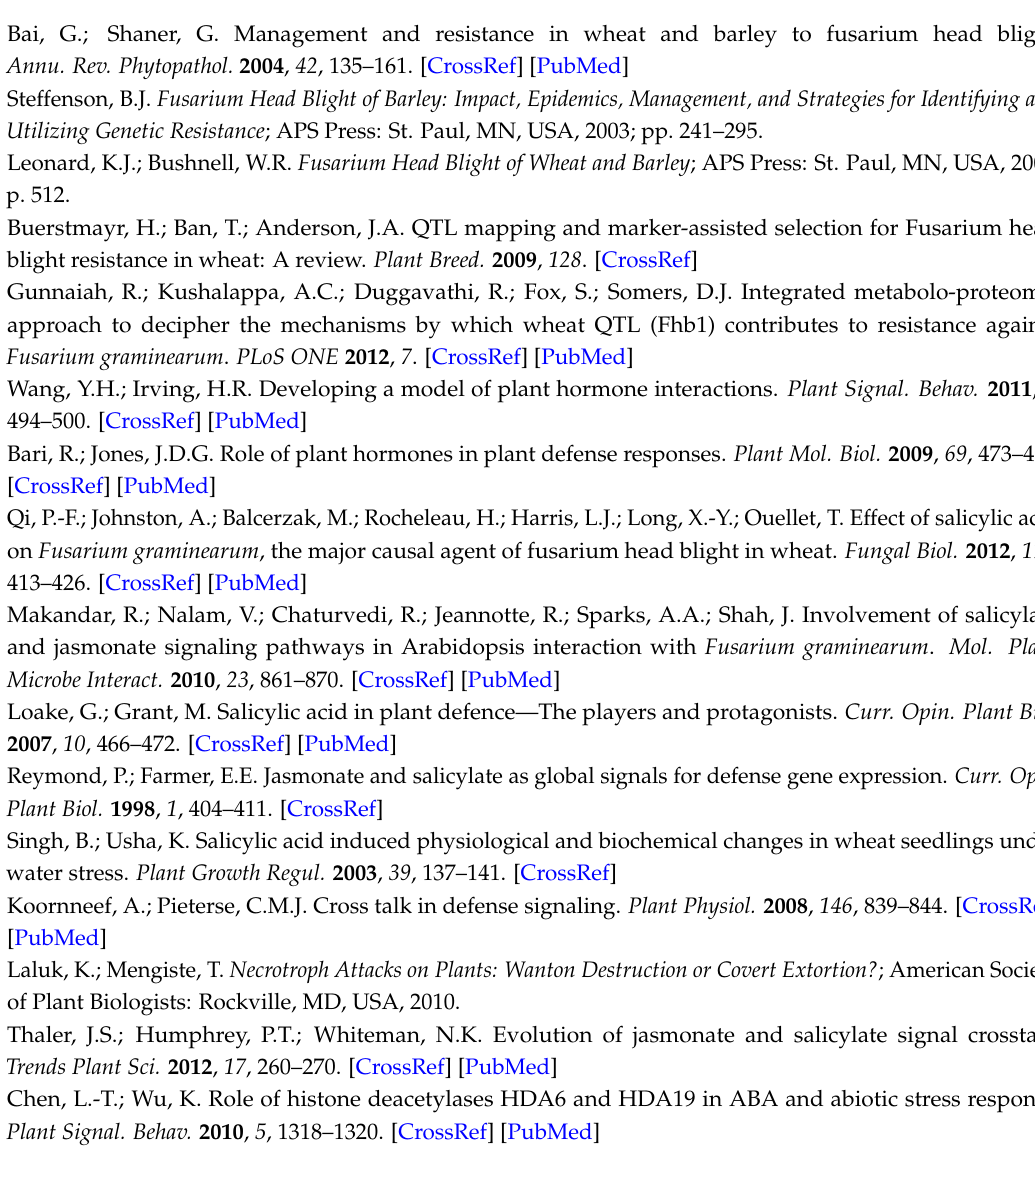
Table S1: List of resistance related metabolites obtained from referenced publications with their plant